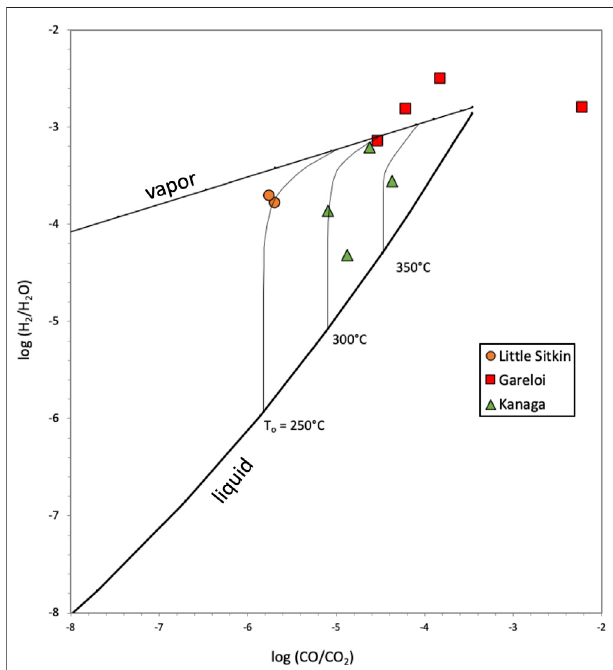
FIGURE 10 | Diagram of relavant redox pairs in hydrothermal gases showing the equilibrium compositions of liquid and vapor and relevant initial liquid temperatures (T o ) (Chiodini and Marini, 1998). The redox conditions are controlled by the f O2 buffer of D ’ Amore and Panichi (1980). Most sampleslieintheliquid+vapor fi eldsuggestingatwo-phasehightemperature hydrothermal system at depth.